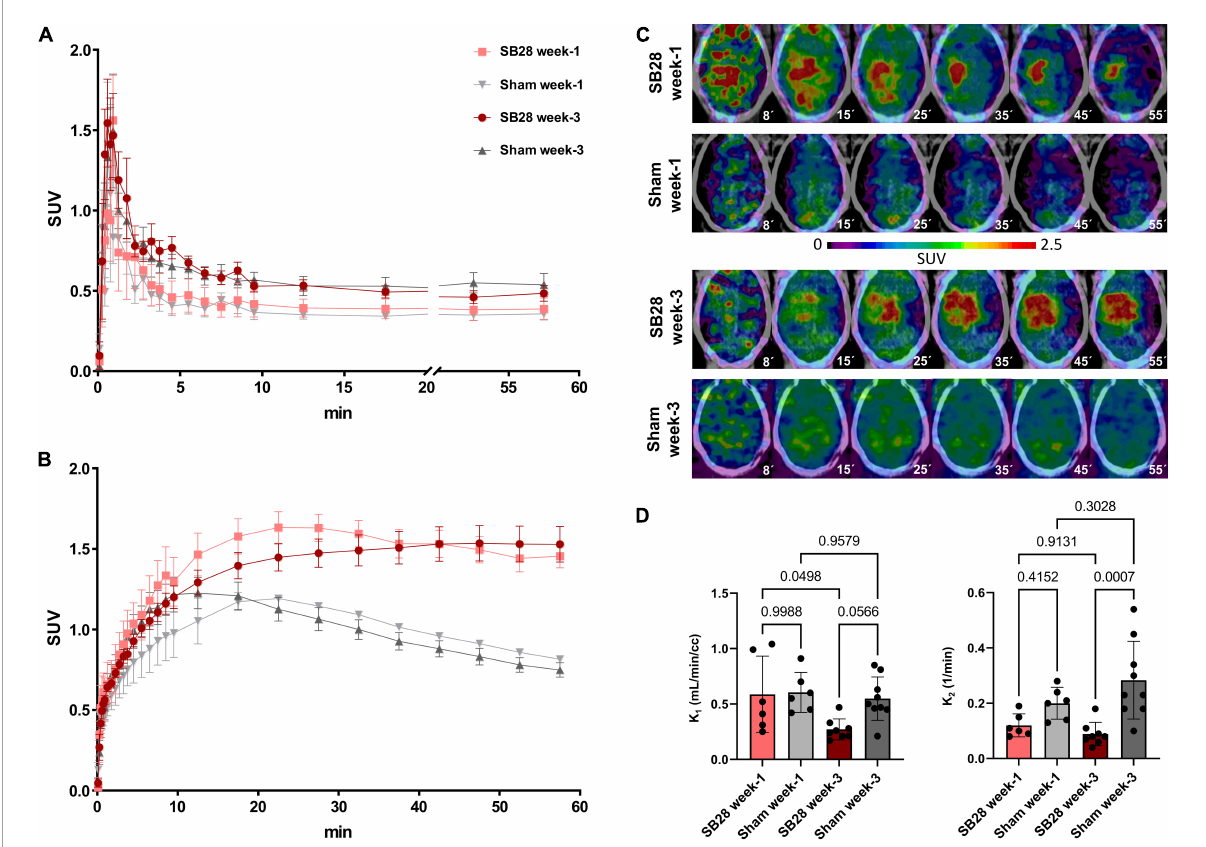
FIGURE1 [ 18 F]GE-180 tracer kinetics in SB28 and sham mice. Time-activity-curves (normalized to standardized uptake values, SUV) of (A) the carotid arteries and (B) the lesion site in SB28 and sham mice at early (week-1) and late (week-3) time-points. Time-activity-curves show the average curve for each group of animals (SB28 and sham) at both time-points. (C) Axial slices of [ 18 F]GE-180 TSPO-PET at different time frames of the 60 min scan duration are shown upon a CT template for representative mice. The median times (minutes) of the illustrated frames are provided below the images. Please note the faster tracer uptake and the higher washout in the early SB28 mouse when compared to the late SB28 mouse. (D) Comparison of the uptake rate constant K 1 and the dissociation rate constant K 2 between SB28 and sham mice at early (week-1) and late (week-3) time-points. K 1 and K 2 were derived from a one tissue compartment model using the image derived carotid artery input function. P -values are indicated for comparisons of SB28 and sham mice per time-point and for the comparison of week-1 (SB28 n = 6, sham n = 6) and week-3 (SB28 n = 8, sham = 9) within